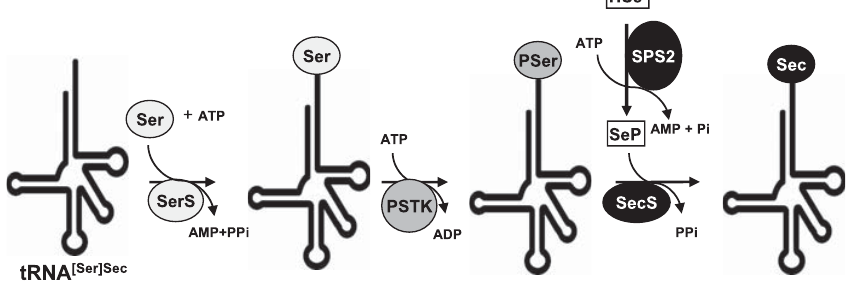
Figure 6. Sec Biosynthesis in Eukaryotes The pathway of Sec biosynthesis is shown (see text for details and abbreviations are defined in the text with the exception of SerS [seryl-tRNA synthetase] and PSTK [ O -phosphoseryl-tRNA [Ser]Sec kinase]).